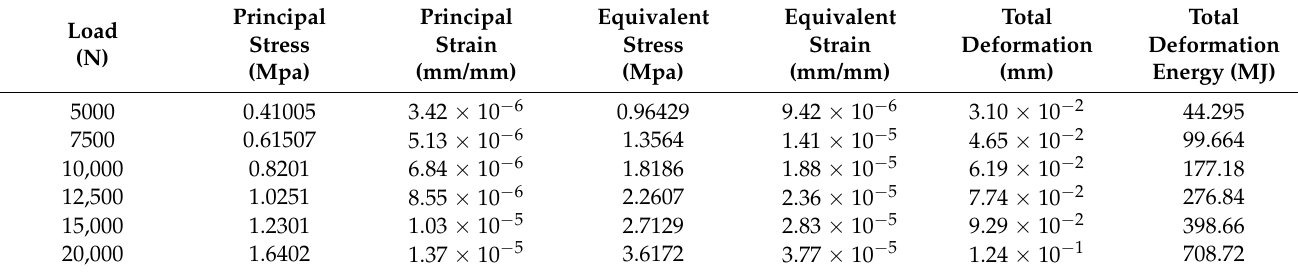
Table A2. Strain and stress isostatic parameters of the “Tianya” abyss lander.